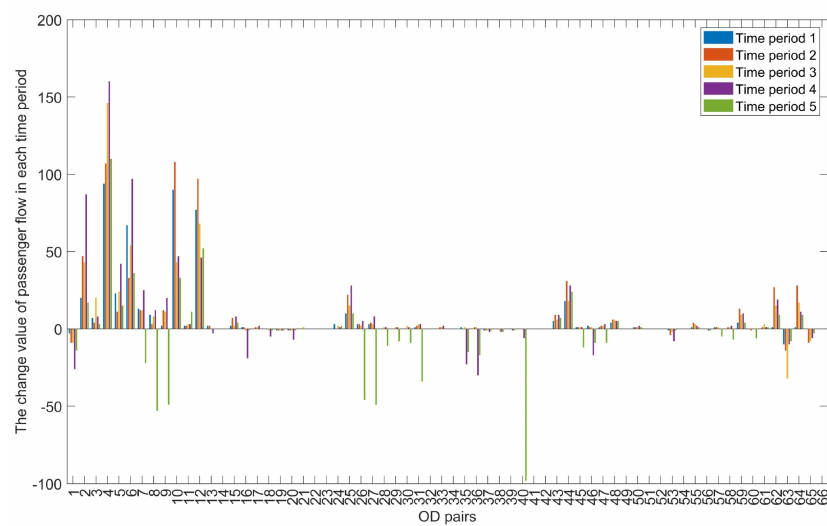
Figure 14. The distribution of passenger numbers among all ODs and time